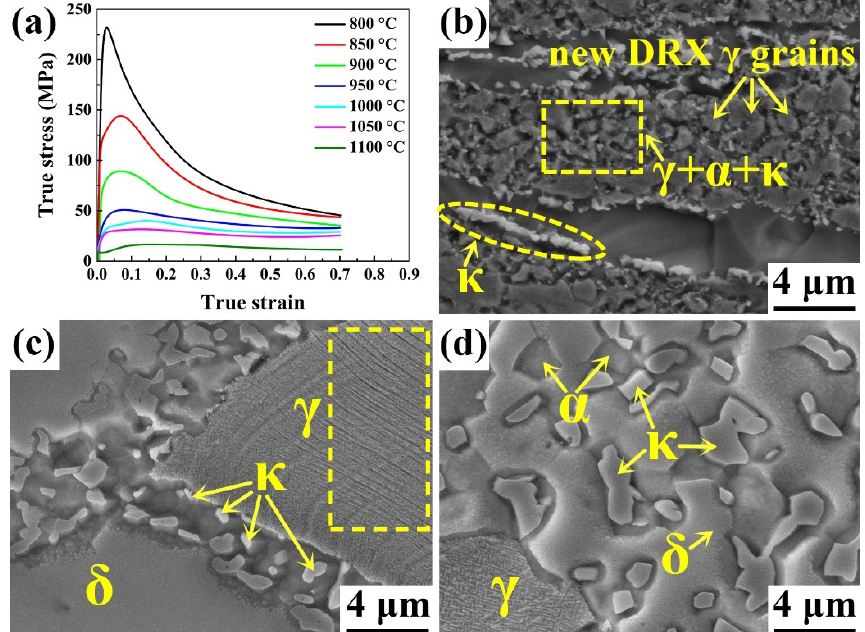
Figure 8. ( a ) Flow curves of the Fe-11Mn-10Al-0.9C medium-Mn duplex lightweight steel deformed at the strain rate of 0.001 s − 1 and ( b − d ) microstructural evolution showing the dynamic precipitation of GB κ -carbides at the deformation temperature of 800 °C under various strain rates of ( b ) 10 s − 1 , ( c ) 0.01 s − 1 , ( d ) 0.001 s − 1 [181]. (Reproduced with permission from [181]. Copyright 2020 Elsevier).